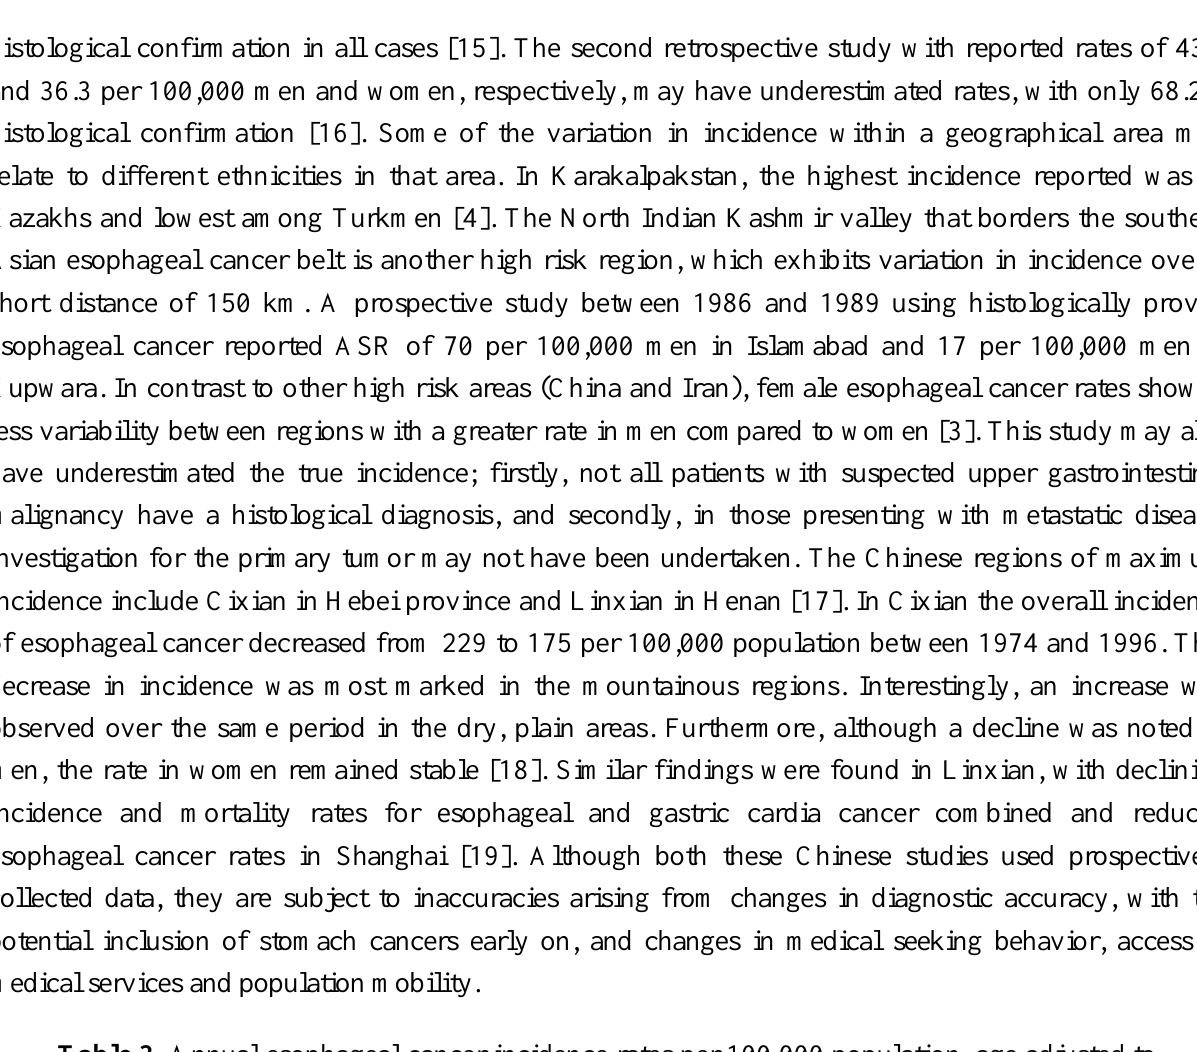
Table 3. Annual esophageal cancer incidence rates per 100,000 population, age adjusted to the world population for the Central Asian Republics of the Central Asian Esophageal Cancer Belt, taken from GLOBOCAN 2002